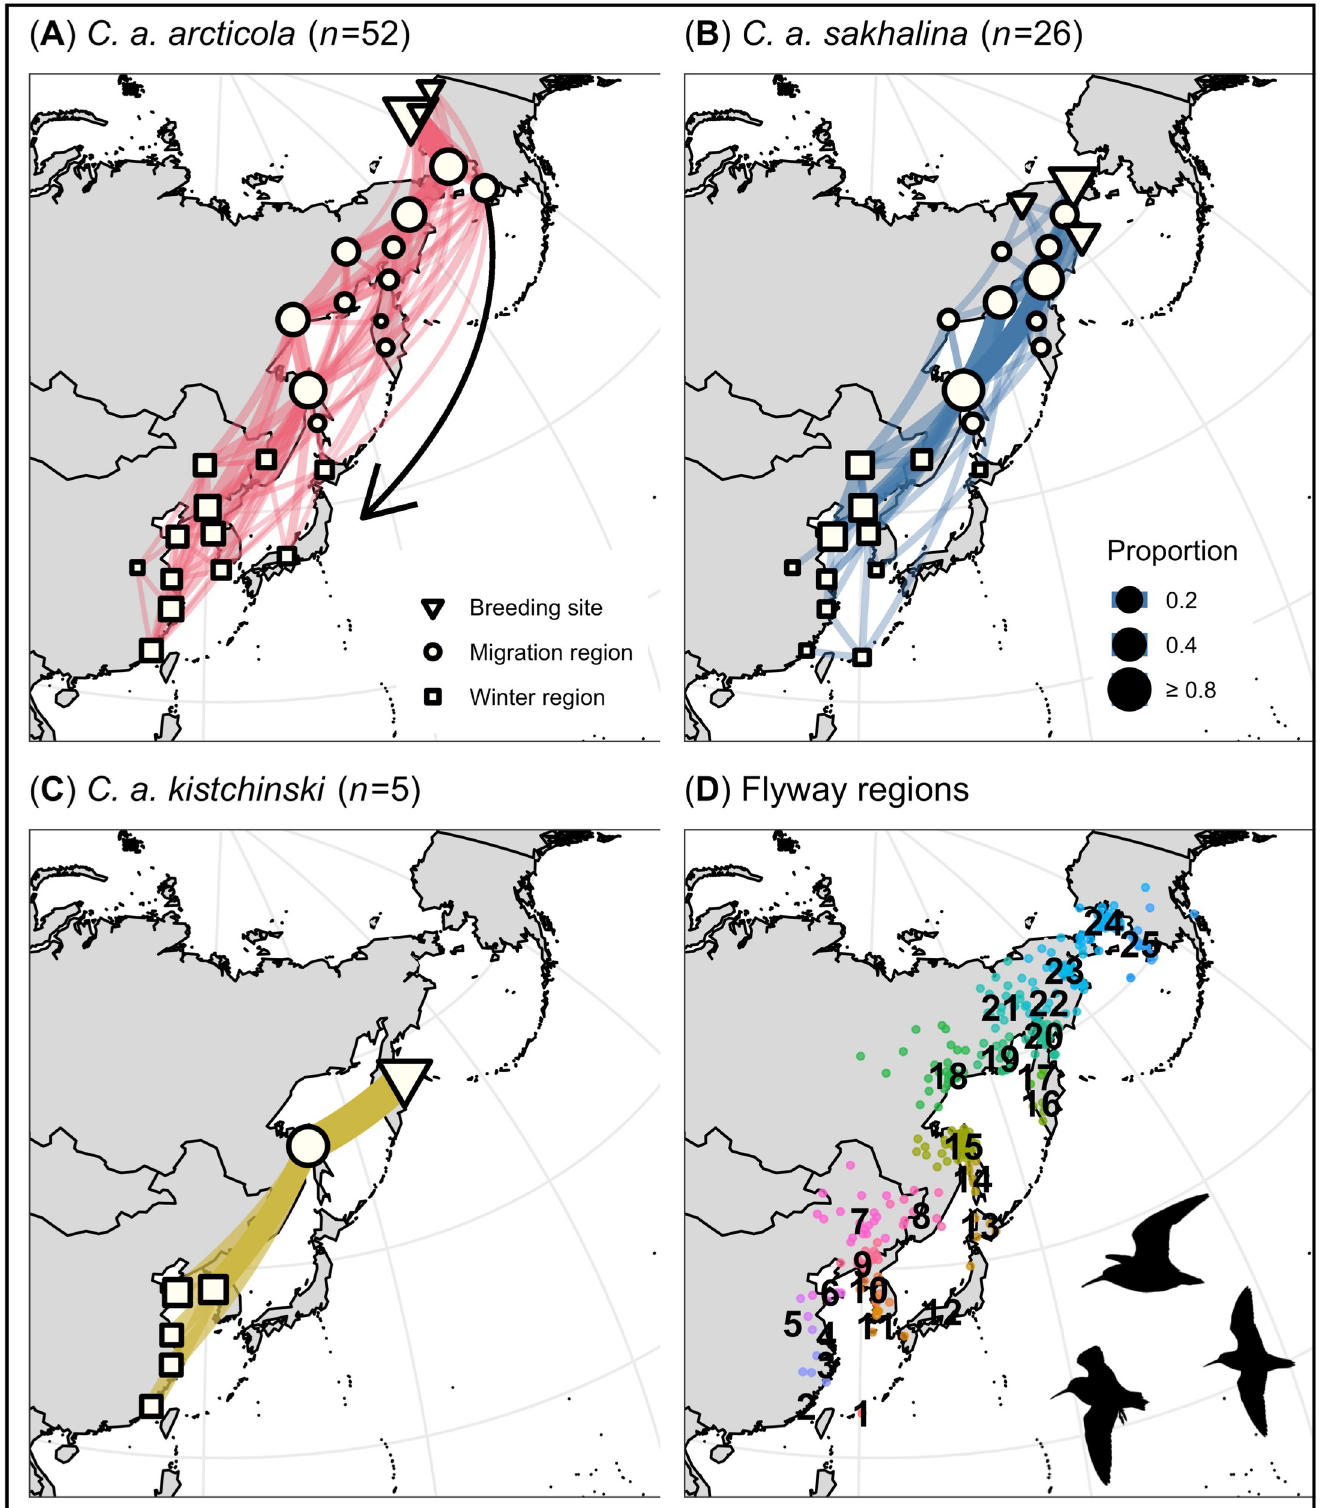
Fig 2. Migratory network depicting south migration movements made by Dunlin subspecies along the East Asian–Australasian Flyway, and (D) south migration stationary estimates color-coded by flyway region. Network nodes and edges are weighted by the proportion of individuals that stopped in each flyway region, and the proportion that migrated between flyway regions,